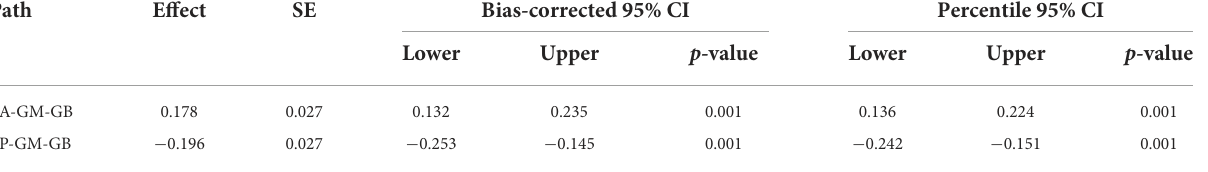
TABLE 9 Standardized bootstrap mediation effect